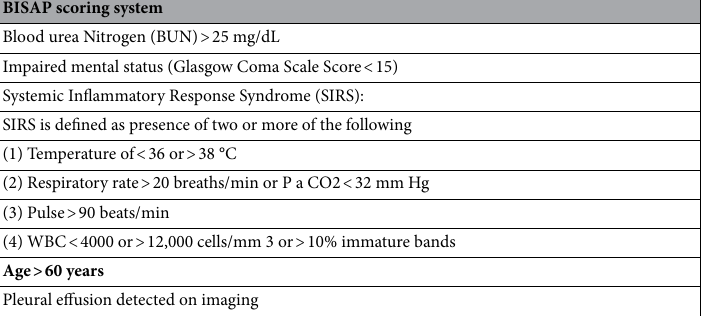
Table 4. BISAP scoring system. BISAP bedside index of severity in acute pancreatitis, WBC white blood count. One point is assigned for each variable within 24 h of presentation and added for a composite score of